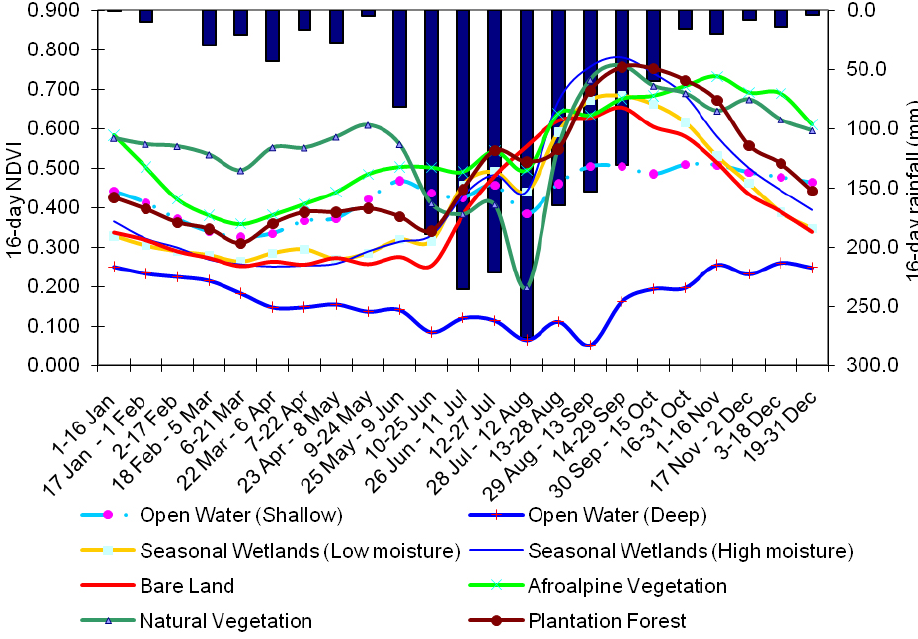
Fig. 7. The time-series characteristics of the wetlands and non wetlands (Mean 16-day 4 annual NDVI and rainfall for the period 2001 to